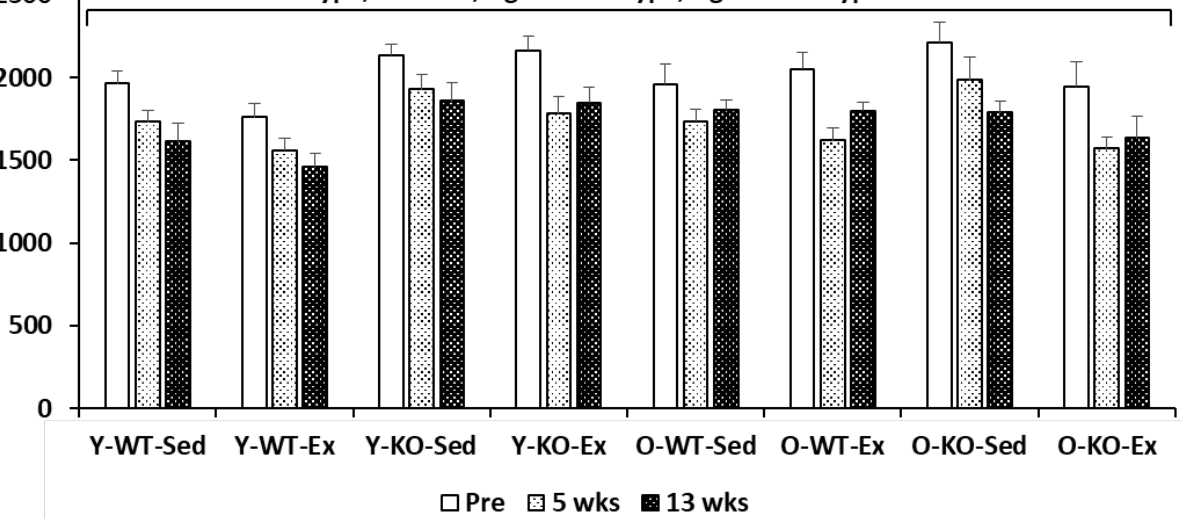
Figure 1. Oral Glucose Tolerance Test. Glucose tolerance decreased with Sparc KO and increased with exercise. The ageing also decreased the glucose tolerance only in WT mice (not in Sparc KO mice). The 4-way ANOVA analysis also revealed an interaction (age × genotype × exercise) in which ageing decreased the tolerance only in WT-Ex mice (not WT-Sed mice) and increased the glucose tolerance in KO-Ex mice (not KO-Sed mice). All data are mean ± SEM. The number of mice: 11–12 mice per experimental condition. Abbreviations: AUC, area under the curve; Ex, exercise; KO, knockout; O, old; Sed, sedentary; Sparc , secreted protein acidic and rich in cysteine; WT, wild-type; Y, young.